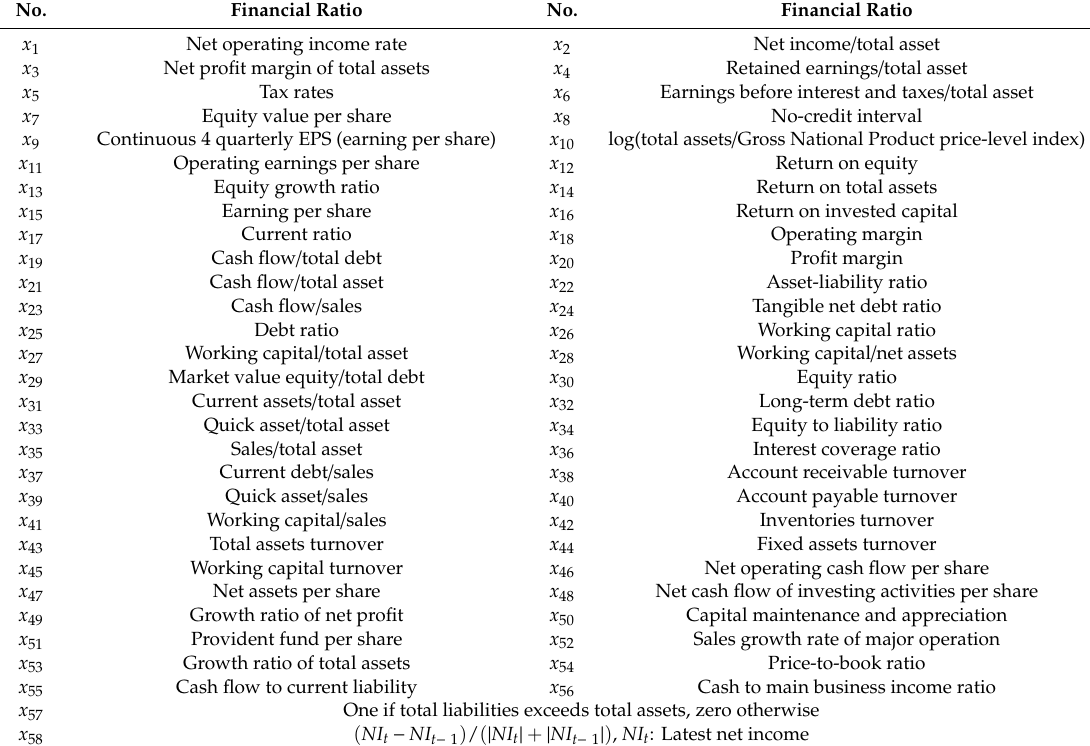
Table A2. Financial ratios widely adopted in prior studies for corporate failure forecasting.